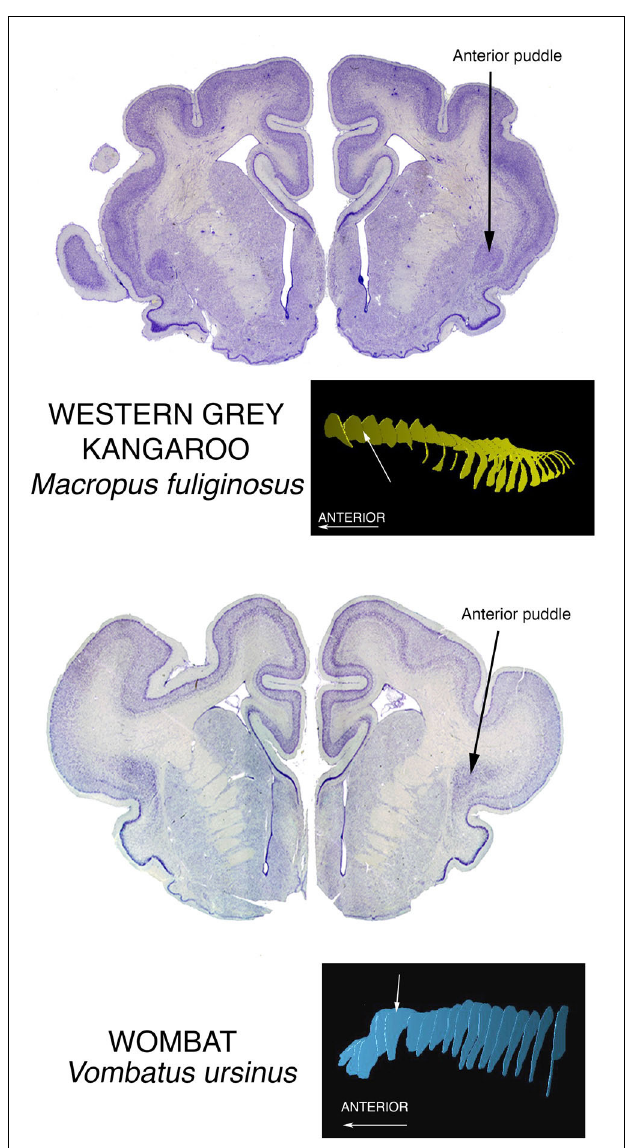
FIGURE 6 | Nissl stained coronal sections through the brains of two large marsupials show the Anterior Puddle seen in all marsupials of whatever body